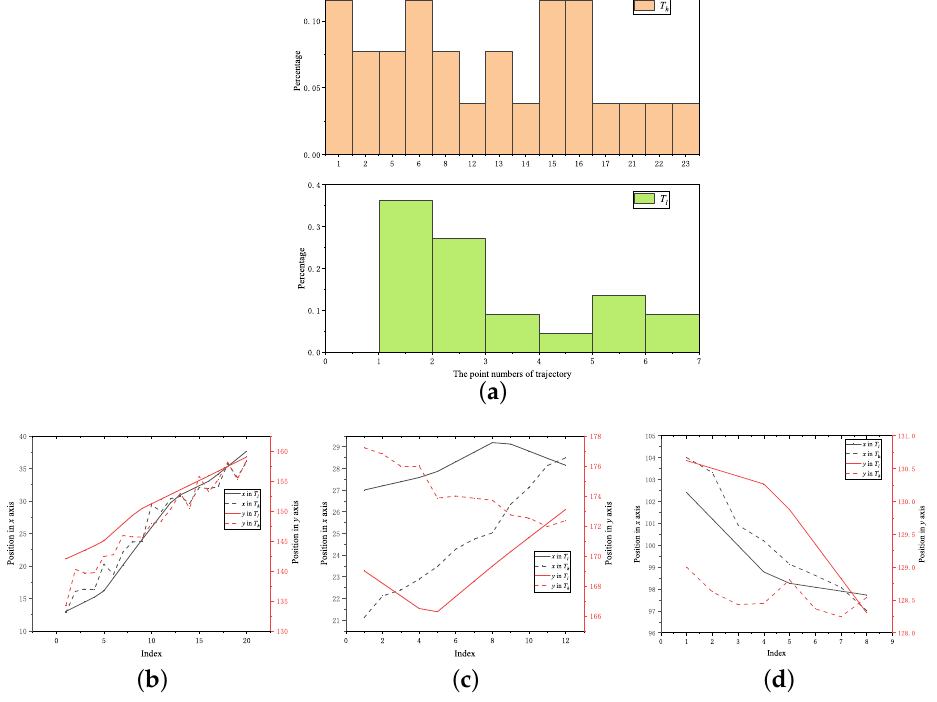
Figure 14. ( a ) Histogram of trajectory point numbers. ( b ) Whitecap neighbor feature optical flow trajectories of C 4 . ( c ) Sun glint neighbor feature optical flow trajectories of C 4 . ( d ) Sun glint neighbor feature optical flow trajectories of images in Figure